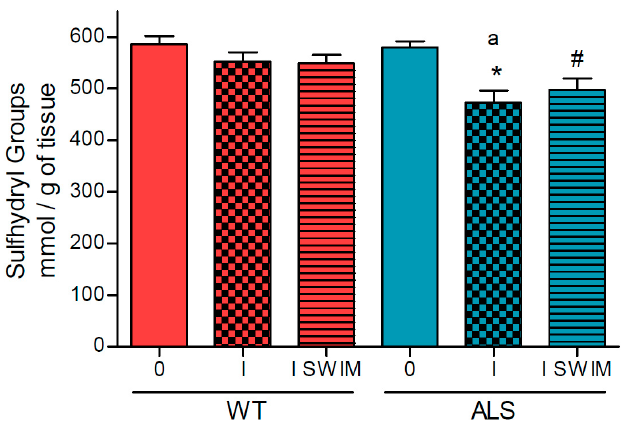
Figure 5. Oxidative stress parameters (sulfhydryl groups) in skeletal muscle homogenates of the ALS and WT mice. Sulfhydryl groups were measured in skeletal muscle homogenates. There were significant differences between the groups: * p = 0.0019 vs. ALS 0, # p = 0.03 vs. ALS 0; and a p = 0.038 between the indicated ALS and corresponding WT groups. The data are presented as the means ± SEM ( n = 8 in each group).